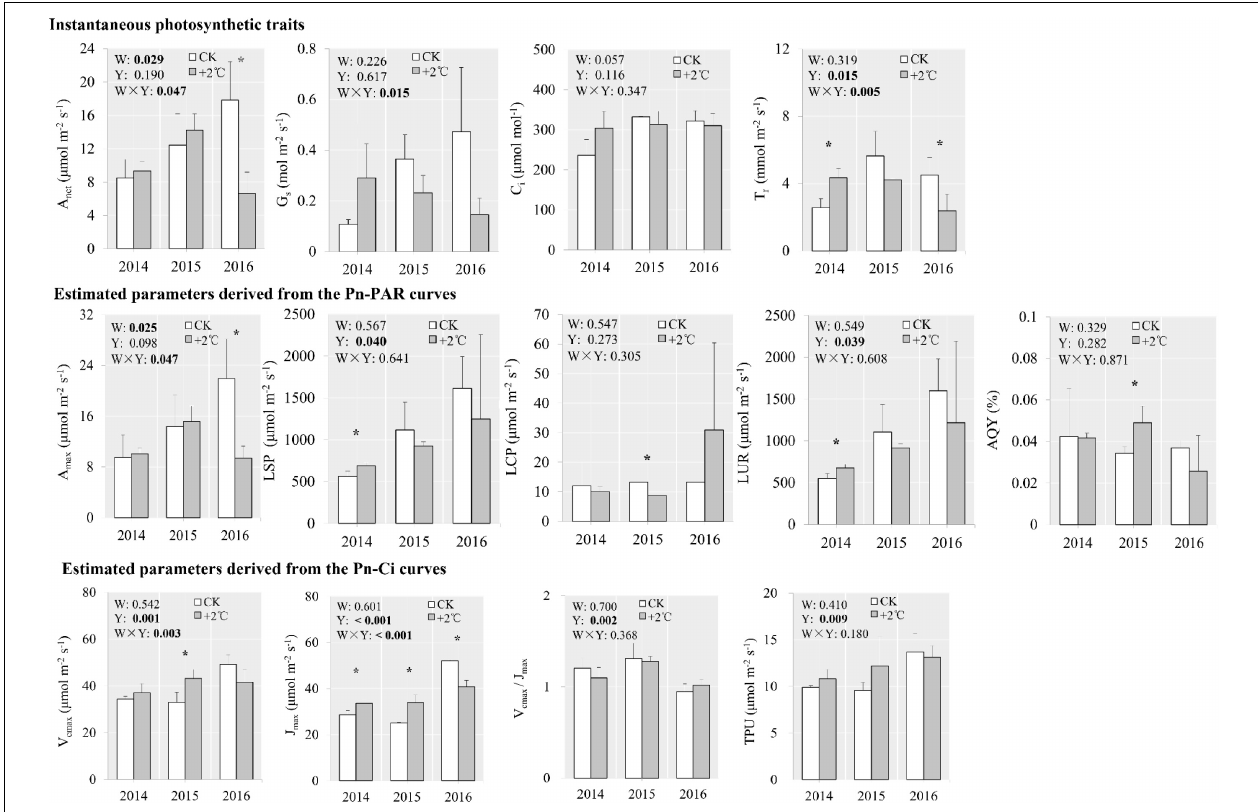
FIGURE 2 | Photosynthetic traits of S. tabernaemontani leaves under CK and +2 ◦ C warming scenario using OTCs. Significance tests for warming ( W ), observed year ( Y ), and the interaction term ( W × Y ) under repeated-measures ANOVA are presented for each variable integrated across the different years ( p -values less than 0.05 are in bold). Within each year, variables that responded significantly to warming are indicated by asterisks (*** p < 0.001; ** p < 0.01; * p < 0.05). Error bars indicate standard deviations. Variable descriptions: A net , light-saturated net photosynthesis; G s , stomatal conductance; C i , intercellular CO 2 concentration; T r , transpiration rate; A max , light- and CO 2 -saturated net photosynthesis; LSP, light saturation point; LCP, light compensation point; LUR, light utilization range; AQY, apparent quantum yield; V cmax , maximum RuBP-saturated carboxylation capacity; J max , maximum capacity for electron transport contribution to RuBP regeneration; V cmax / J max , the ratio of V cmax to J max ; TPU, triose-phosphate utilization